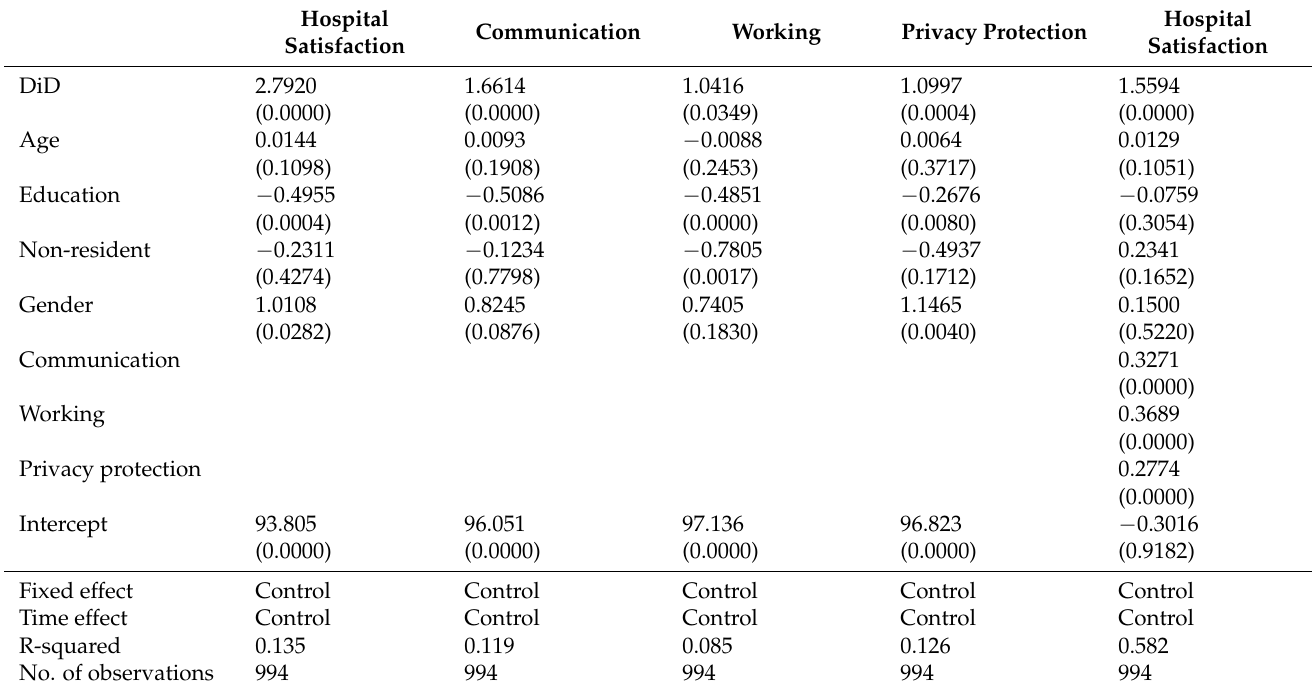
Table 4. Difference-in-difference of hospital